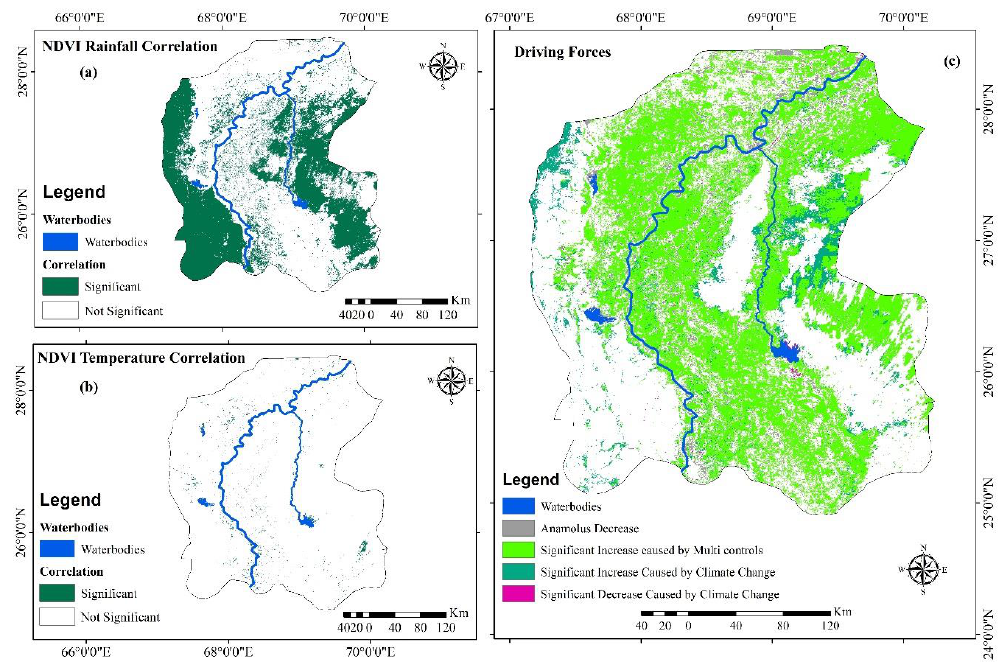
Figure 6. ( a ) Spatial pattern of GSN and rainfall correlation significance, ( b ) spatial pattern of GSN and temperature correlation significance, and ( c ) driving forces distribution of vegetation dynamics.